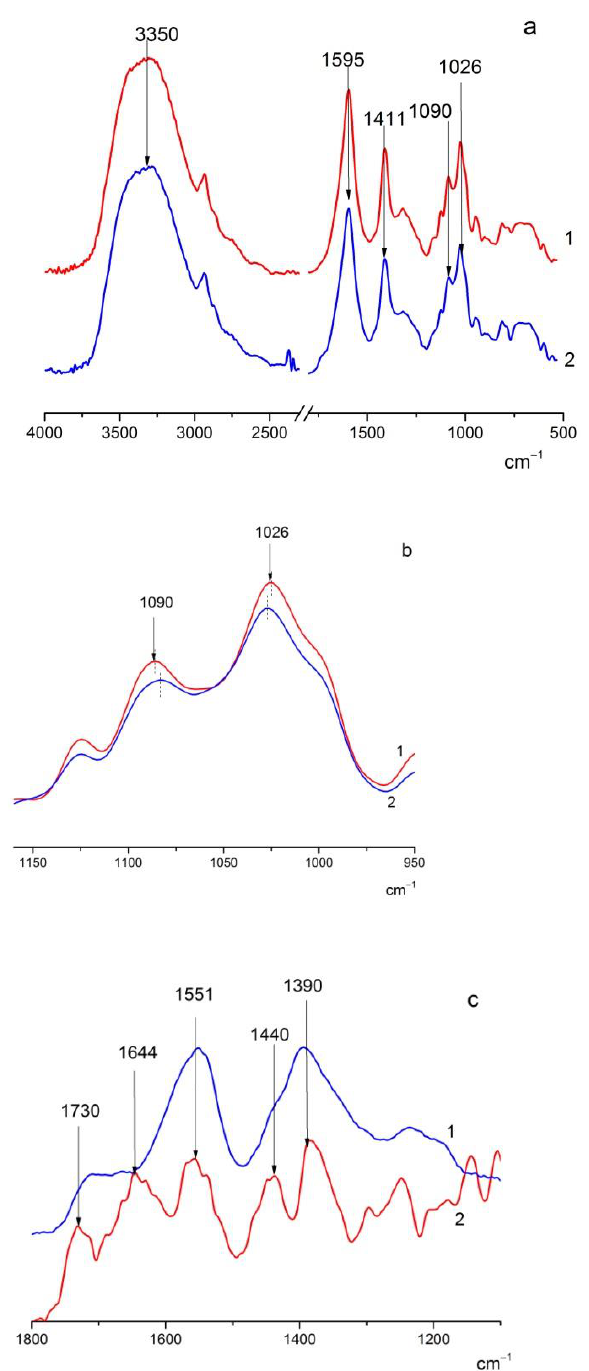
Figure 1. FTIR spectra of the studied films. ( a ): (1) sodium alginate (ALG) and (2) ALG-ceria nanoparticles (CeONPs); ( b ): fragment of spectra 1a on enlarged scale, ALG (1) and ALG(CeONP) (2); ( c ): citrate-stabilized CeO 2 (1) and difference spectrum obtained by subtracting the spectrum of ALG from that of the ALG(CeONP) composite (2).